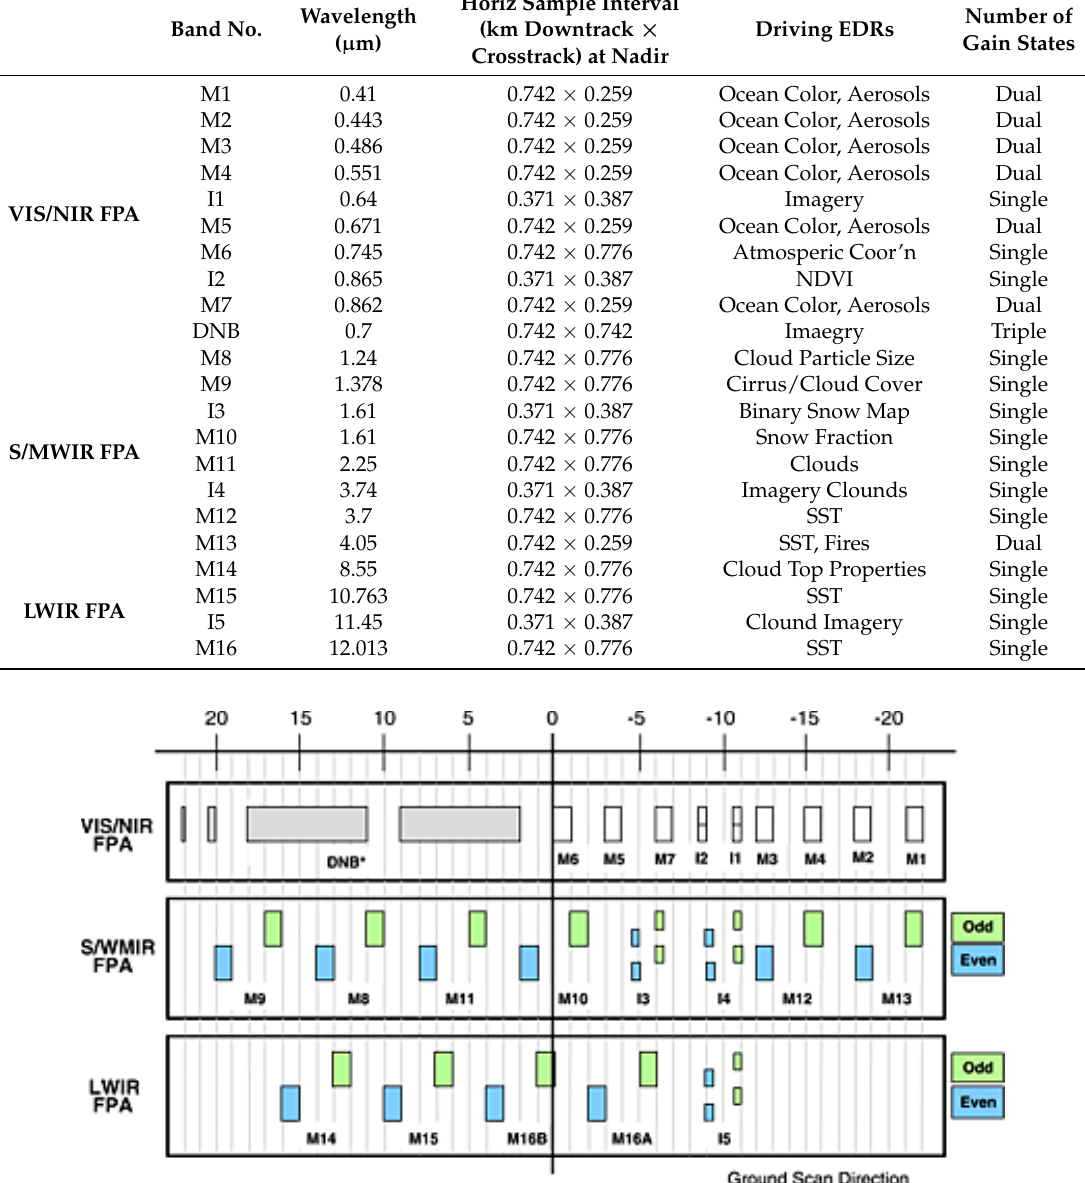
Table 1. Suomi National Polar-orbiting Partnership (SNPP) Visible Infrared Imaging Radiometer Suite (VIIRS) center wavelengths, key specifications, and applications [3,6].